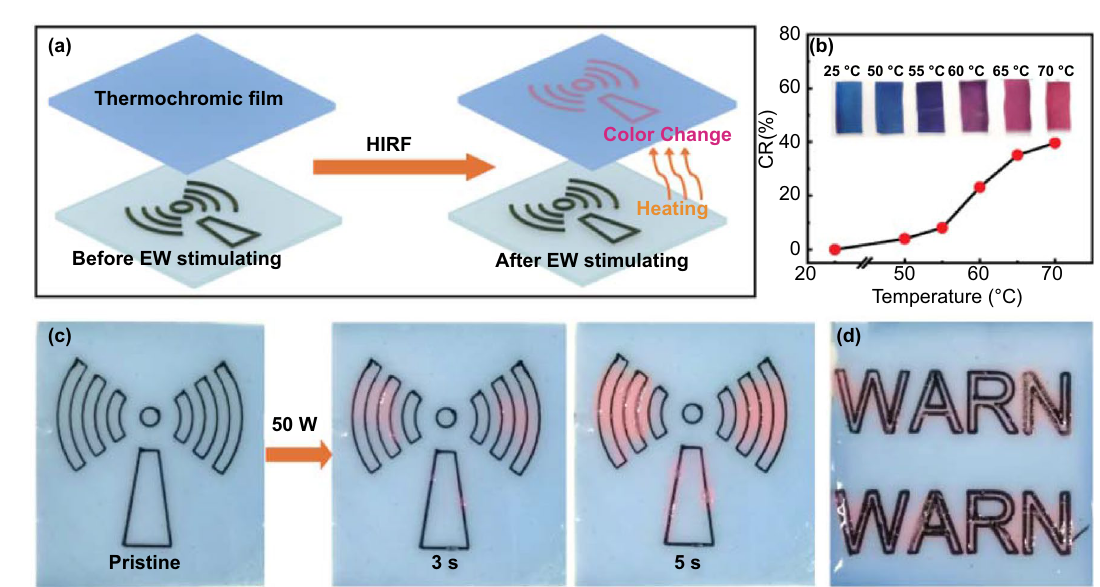
Fig. 5 a Schematic of the fabrication of high‑intensity radiated field (HIRF) responsive materials. b Colorimetric response (CR) values of t‑PDMS from 25 to 70 °C. c, d Photographs of thermochromic MG3 patterns stimulated by electromagnetic waves of 2.45